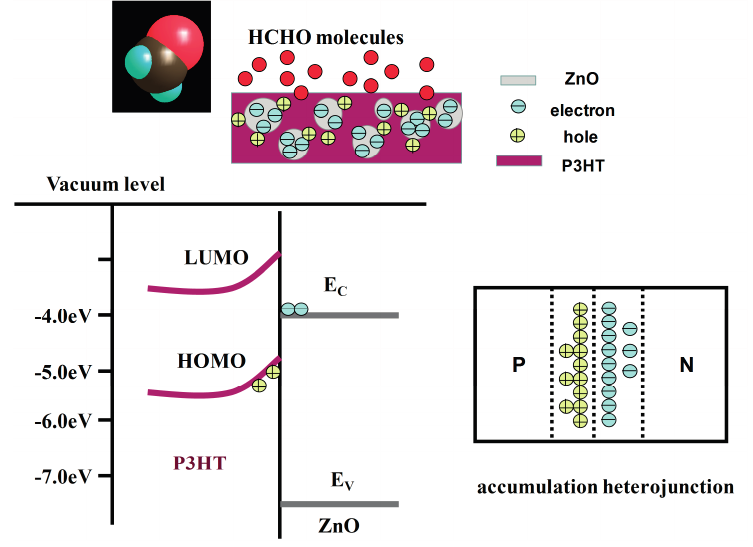
Figure 10. The schematic diagram showing the energy level and charge accumulation of P3HT-ZnO